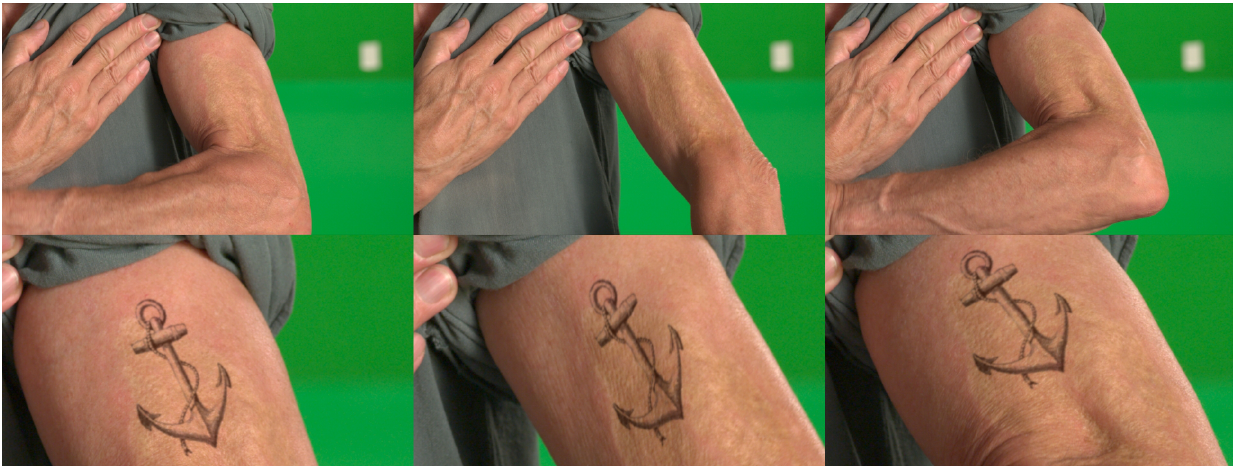
Fig. 7 Samples from the sailor sequence (100 frames) and a closeup of the same samples including the visual